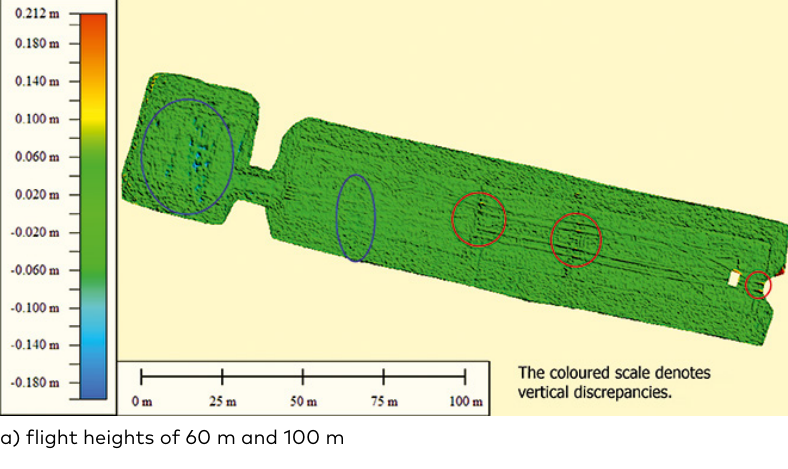
a) flight heights of 60 m and 100